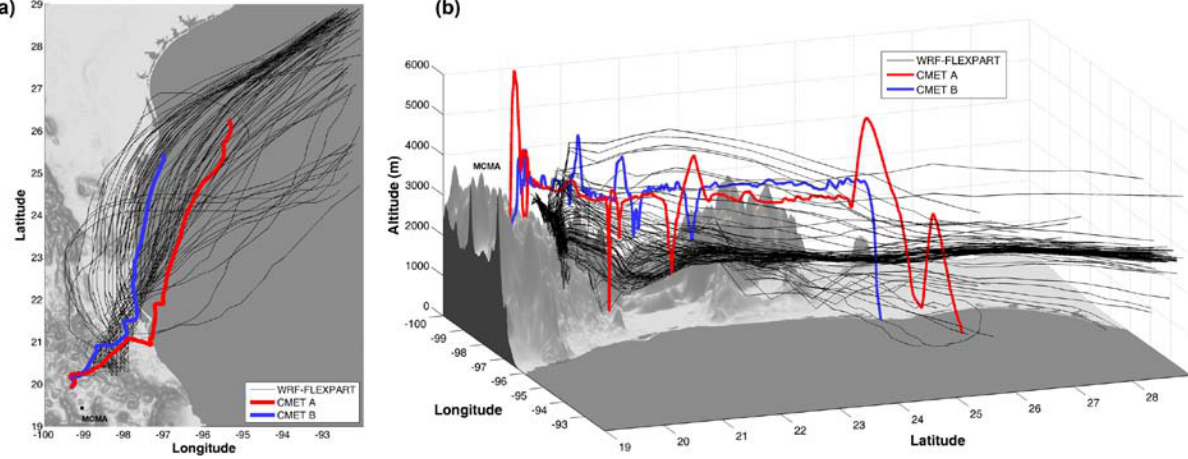
Fig. 17. (a) WRF-FLEXPART trajectories (black) for particles released at 3400m altitude at the time and location of the first CMET balloon launch and advected forward for 24h. The balloon flight tracks are shown in red and blue. (b) Three-dimensional view of the same model run shows how the trajectories follow the terrain down over the Coastal Plain. The balloon profiles in Figs. 10 and 11 imply that the outflow decoupled from the